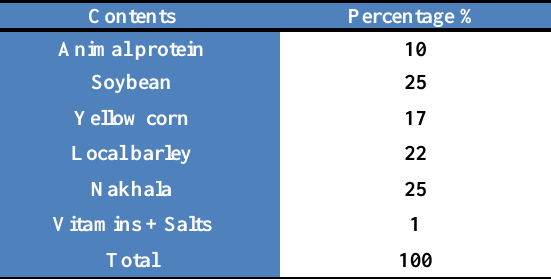
Table, 1: The components of experimental diet according to ( 13 ).